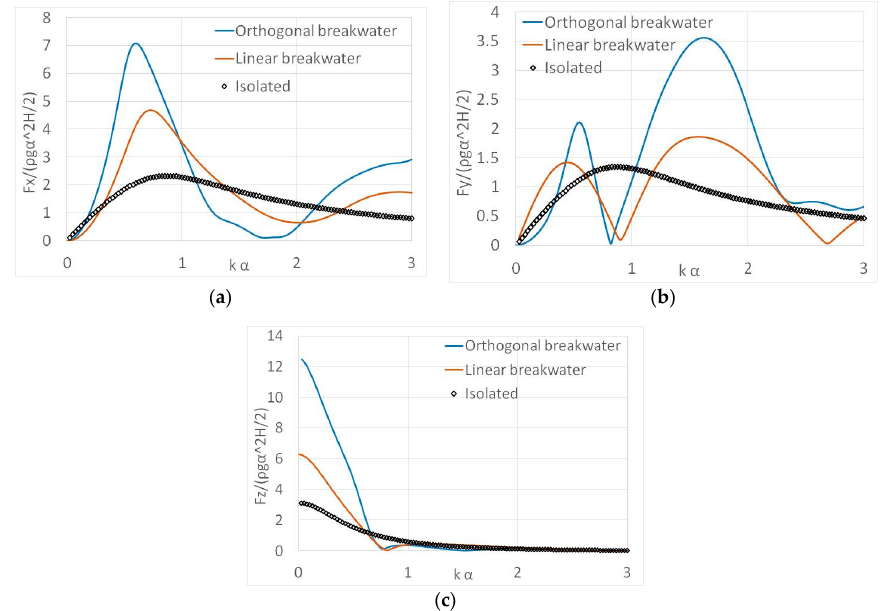
Figure 11. Exciting forces on a floating cylindrical floater placed in front of a linear breakwater using the method of images: ( a ) horizontal-exciting force on x -axis; ( b ) horizontal-exciting force on y -axis; ( c ) vertical-exciting force on z -axis. The results are compared with the corresponding values of the same floater placed in front of a right-angle-shaped breakwater and in isolation condition (i.e., without the presence of the breakwater).